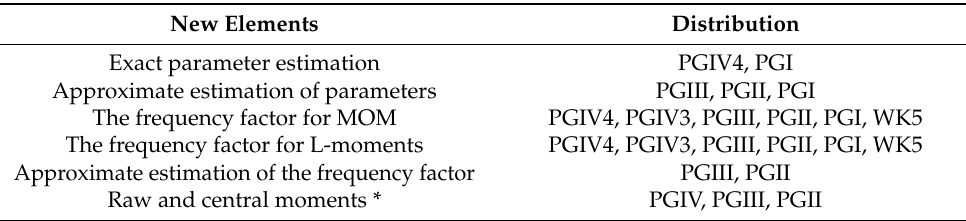
Table 1. Novelty elements. New Elements Distribution Exact parameter estimation PGIV4, PGI Approximate estimation of parameters PGIII, PGII, PGI The frequency factor for MOM PGIV4, PGIV3, PGIII, PGII, PGI, WK5 The frequency factor for L-moments PGIV4, PGIV3, PGIII, PGII, PGI, WK5 Approximate estimation of the frequency factor Raw and central moments *